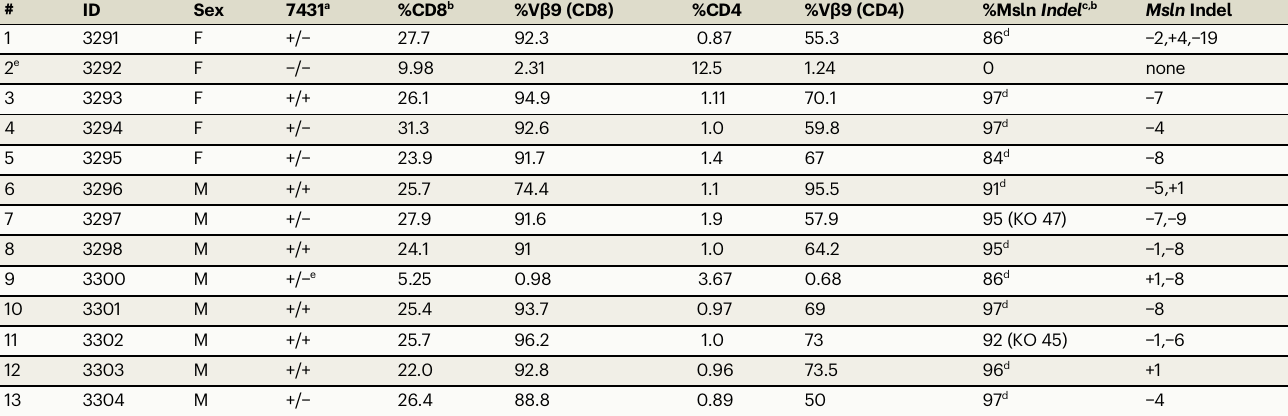
Table 2 | Analysis of T cells and Msln locus from 7431 TRex